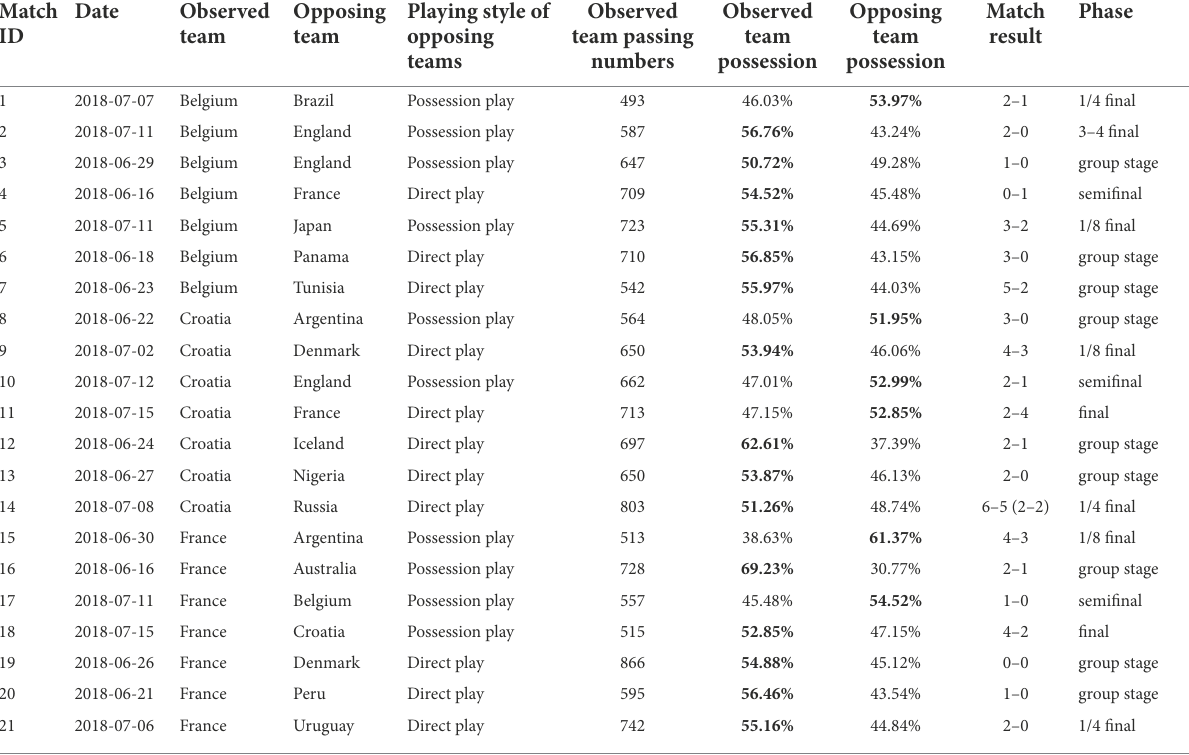
TABLE 1 General description of research